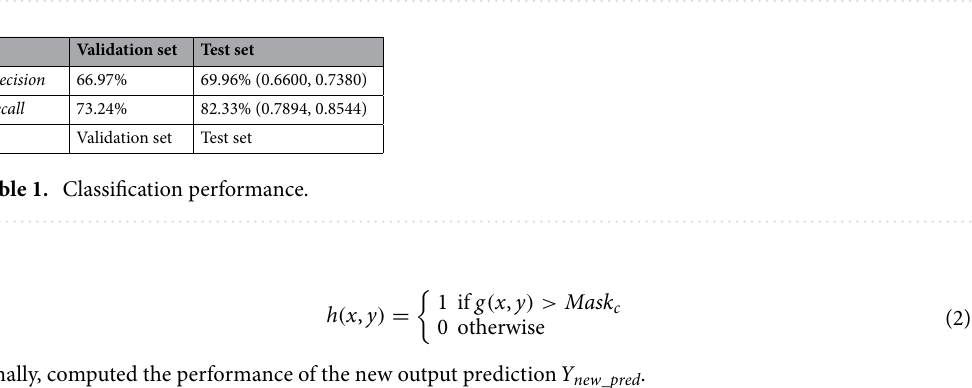
Figure 4. The result in classification. The left is the ROC curve of the classification. At T c = 0.5 , middle shows the confusion matrix from validation set, the right is from the test set.